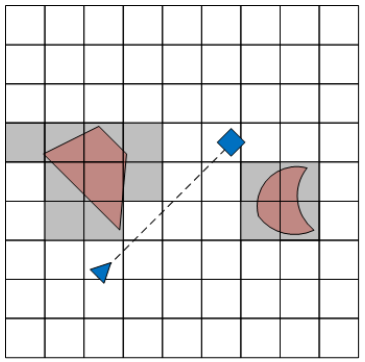
Figure 3. Discretized map with the transformation